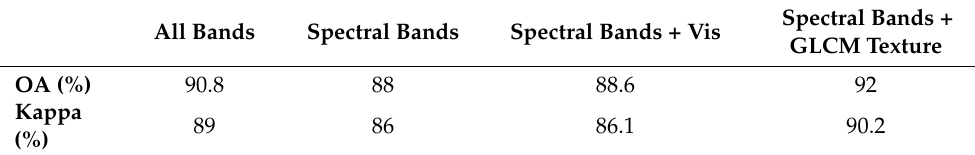
Table 5. OA and kappa for RF classification with different combinations of independent variables.